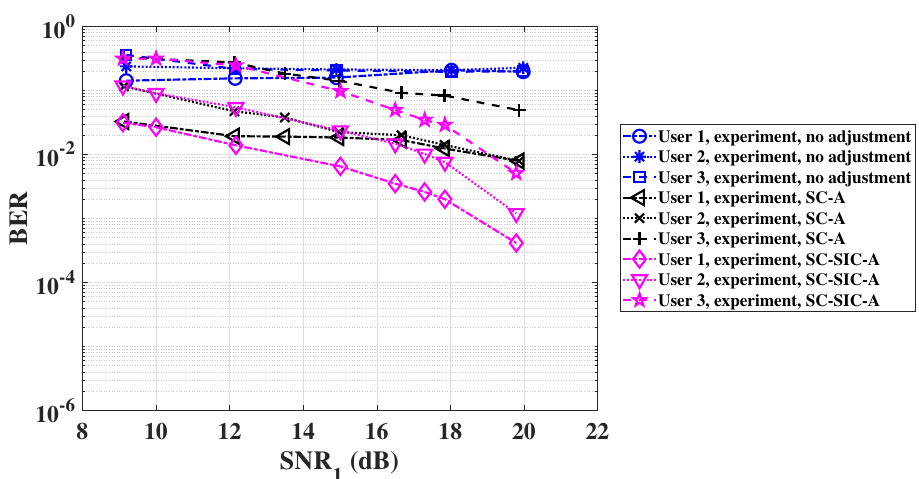
Figure 10. The experimental BER performance for each user of multi-user NOMA VLC system, when K = 3.